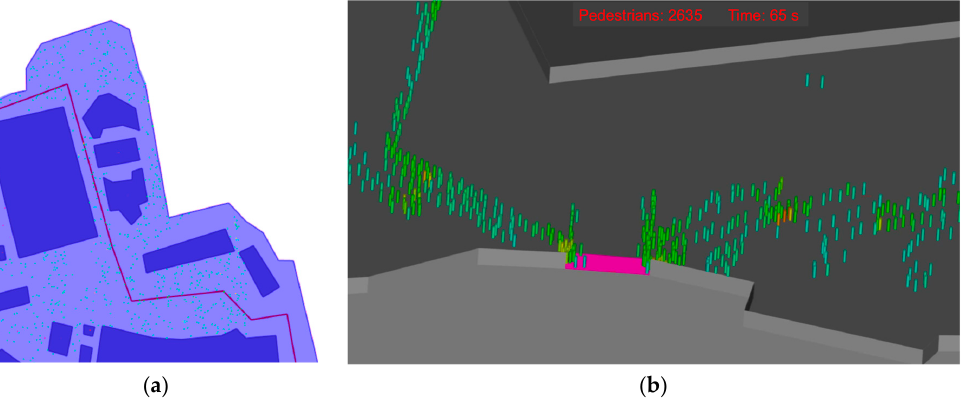
Figure 8. ( a ) A screenshot of the simulation scene seen form above; the red line represents the defined escaping route. ( b ) A closer look at the crowd moving toward a gate during a simulated evacuation. The color of the agent is related to the local density calculated by the